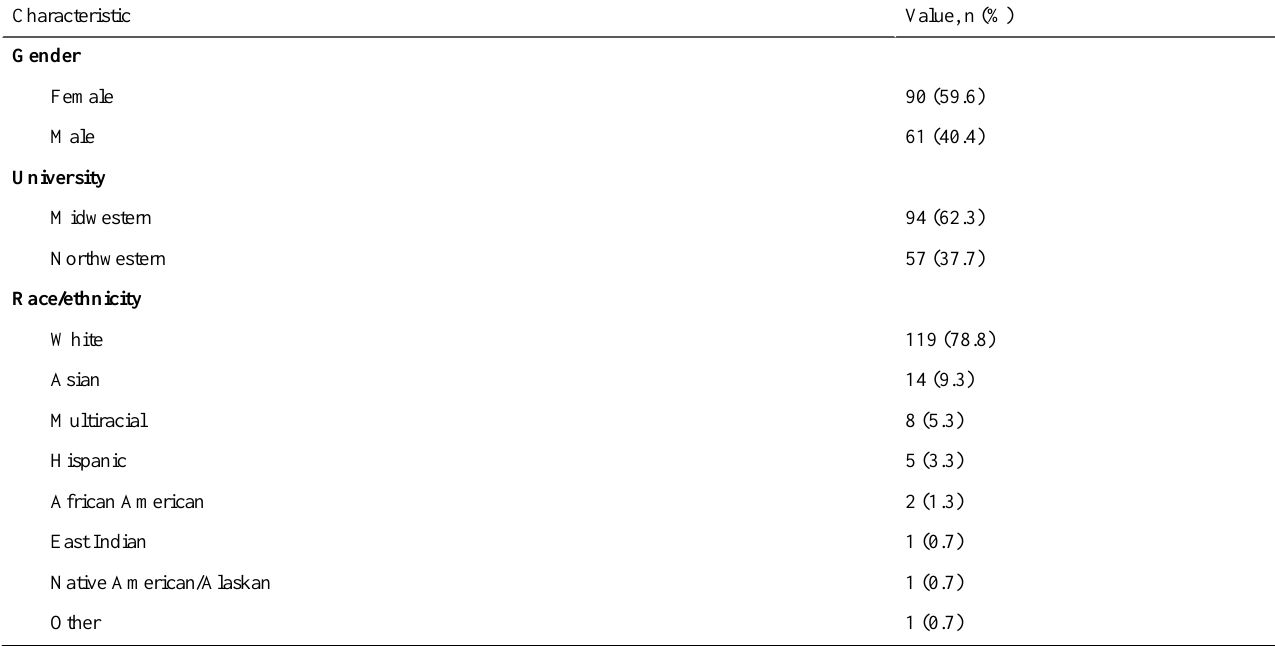
Table 1. Participant